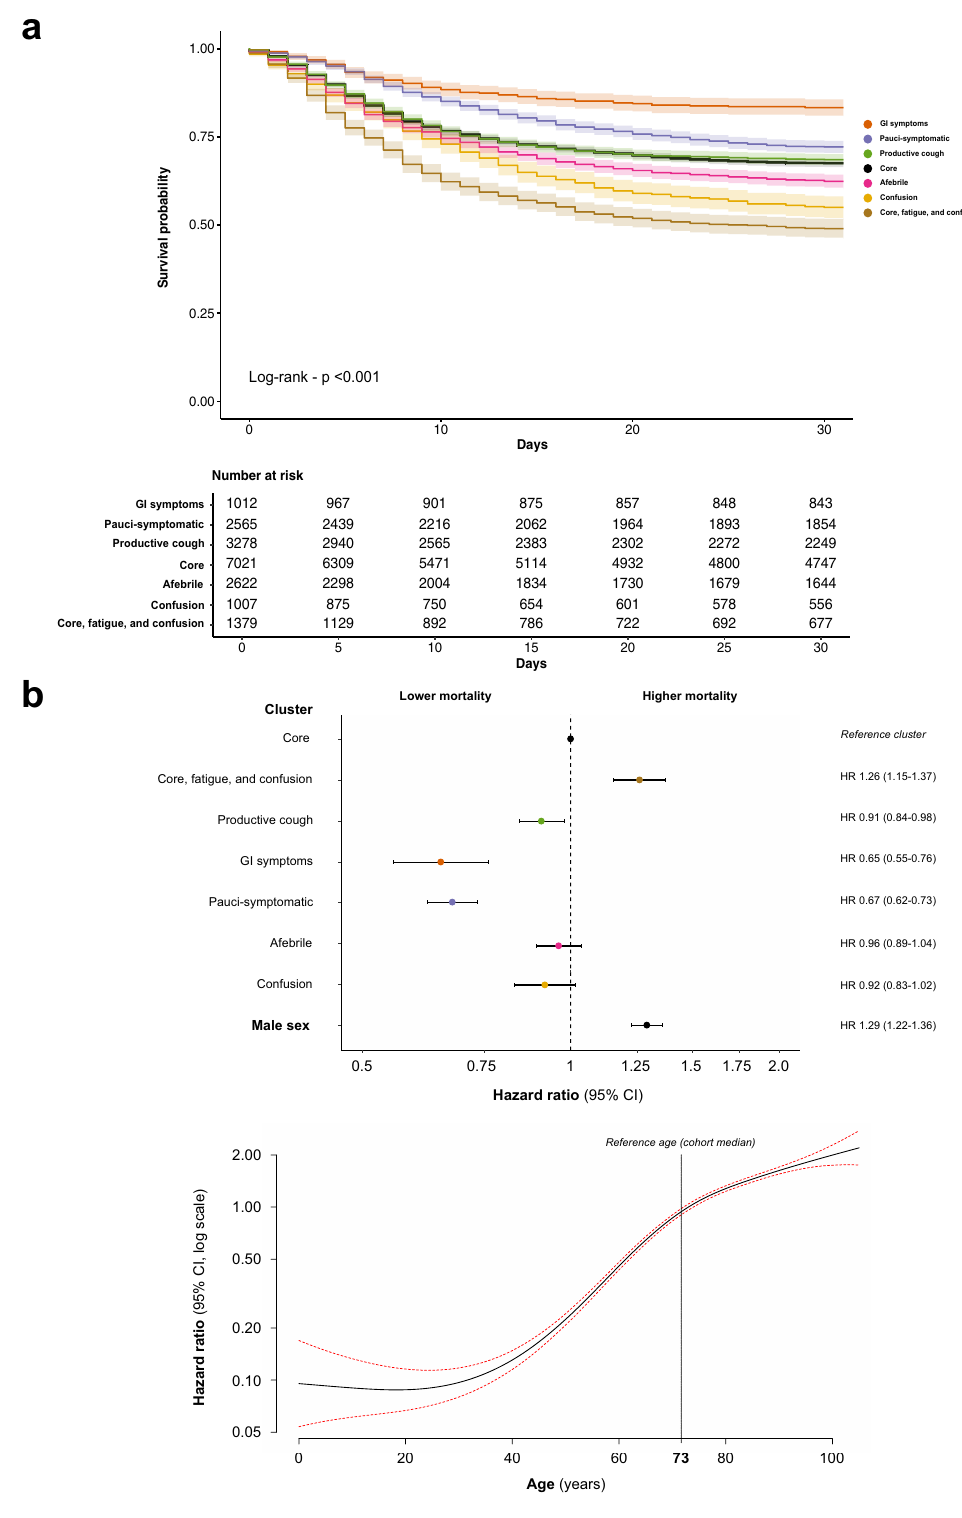
Figure 4. Symptom clusters and survival. ( a ) Unadjusted 30-day in-hospital mortality by cluster. Kaplan-Meier curves, those discharged before 30 days were assumed to have survived until the end of follow-up. ( b ) The risk of 30 day in-hospital mortality, adjusted for age and sex. Upper panel, Forest plot, showing results of a Cox proportional hazards model. Lower panel, Hazard ratio associated with varying age, fitted with psplines. Data are presented as hazard ratio (HR) and 95% confidence intervals. Red dotted line - 95% CI Core symptoms serves as the reference symptom cluster. The cohort median age serves as the reference